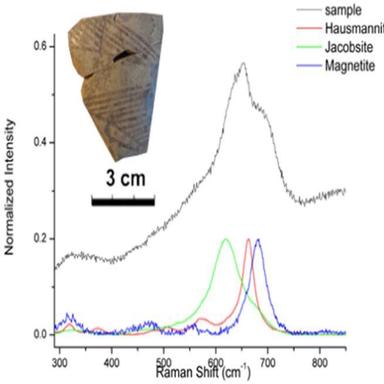
Comparison between Raman spectrum obtained in the black decoration (black) and a reference Me-Fe rocks spectra (taken from the RRUFF™ Project website database ((http://rruff.info/)ff.info/)) (green, red and blue) (sample Rip.1). (For interpretation of the references to color in this figure legend, the reader is referred to the web version of this article.)